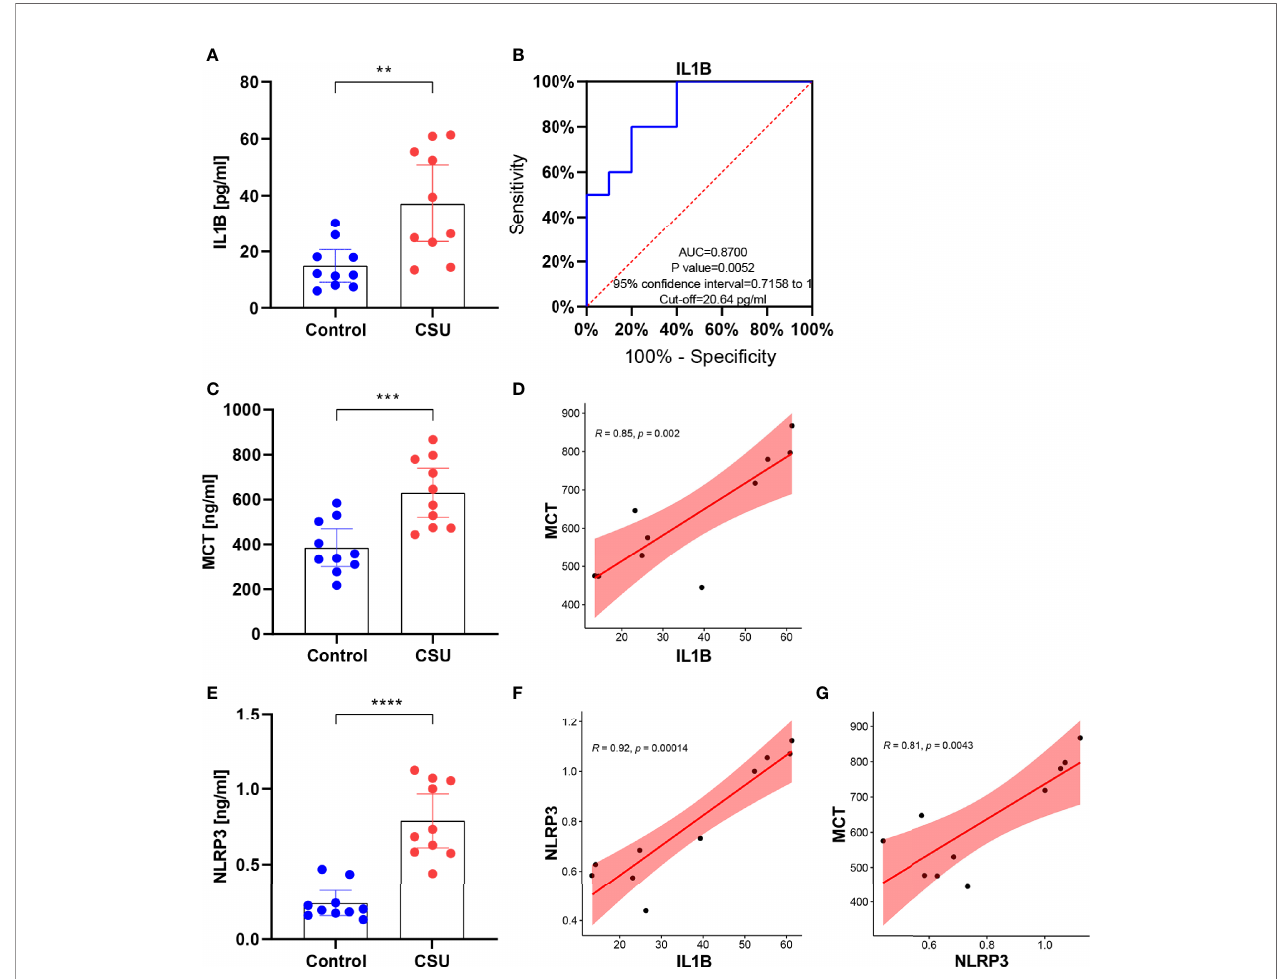
FIGURE 11 | IL1B might participate in activation of mast cells via the NLRP3 in CSU. (A) The expression of IL1B in CSU and control. (B) The ROC curve of IL1B. (C) The expression of MCT in CSU and control. (D) The correlation between IL1B and MCT in CSU. (E) The expression of NLRP3 in CSU and control. (F) The correlation between IL1B and NLRP3 in CSU. (G) The correlation between NLRP3 and MCT in CSU. **p < 0.01, ***p < 0.001, ****p <